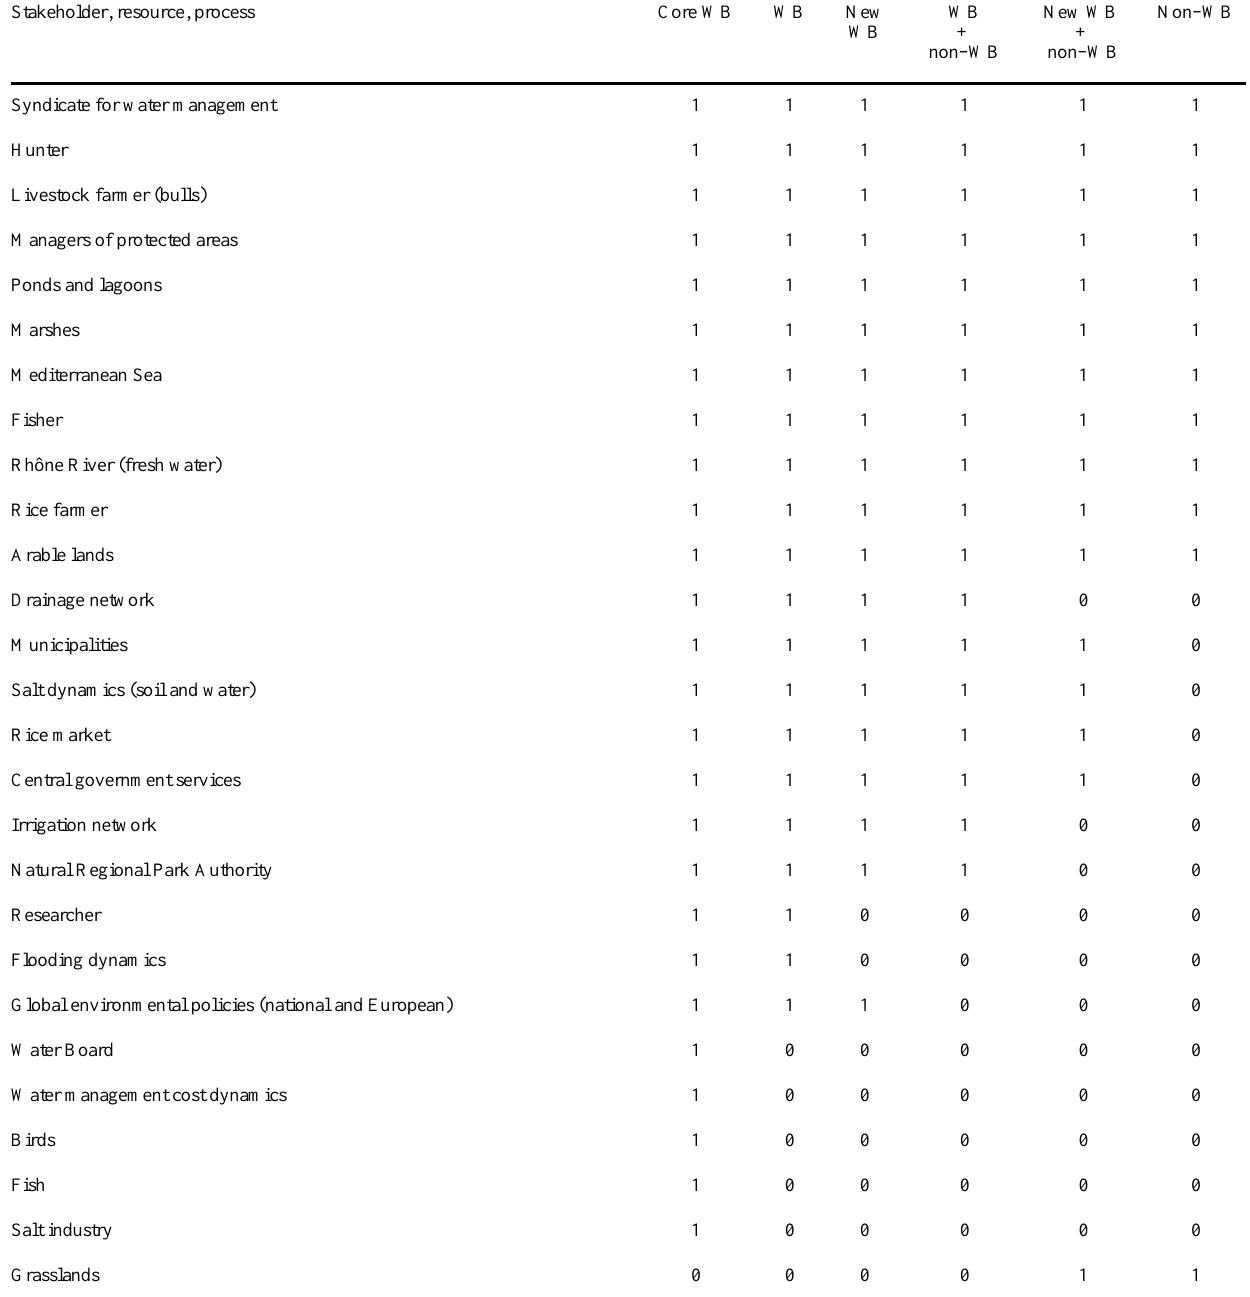
Table 3 . Consensus answer key for whole system mental model of the six sample groups: the core Water Board members (core WB), the Water Board members (WB), the new Water Board members (new WB), all respondents together (WB + non–WB), the new Water Board members and non–Water Board members (new WB + non–WB), and the non–Water Board sample (non–WB). A "1" in each column identifies that stakeholder, resource, or process was included in the consensus mental model of that group, and a "0" indicates that it was